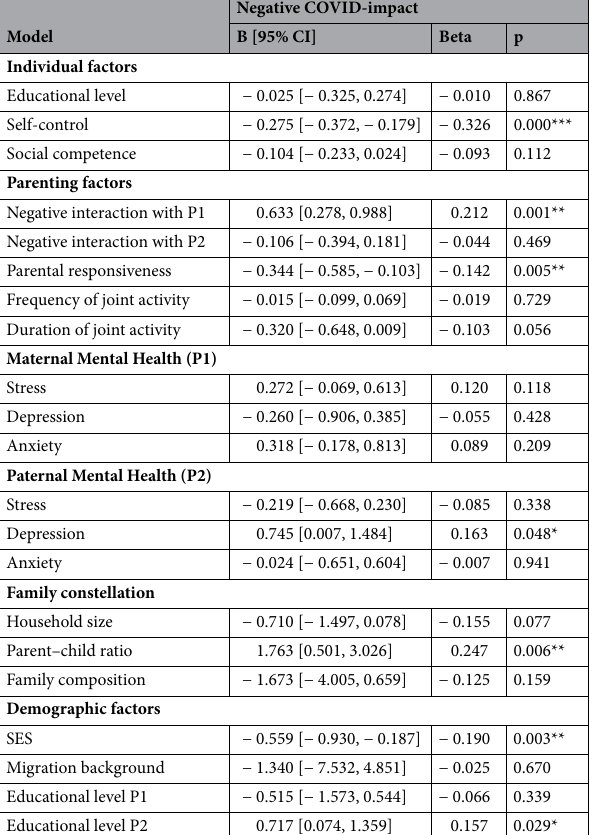
Table 5. Unstandardized (B) and standardized (β) regression coefficients, and significance (p) for all significant predictors in hierarchical regression models. Asterisks signify significant effects, *p < 0.05 & **p < 0.01. P1 = mothers, P2 =